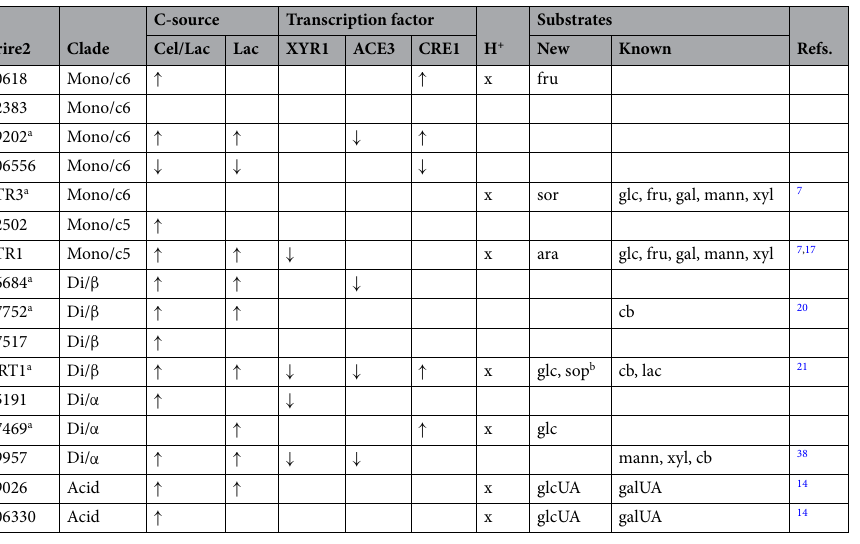
Table 1. T. reesei transporters tested in this study for symport activity in oocytes and their regulation by carbon sources and transcription factors. Clade refers to clades identified from Fig. 1. Significantly differential expression (DE) by carbon sources or by transcription factors was inferred from published studies 23–25,29,36 . Cel/Lac = DE on cellulose or lactose versus d-glucose 36 , Lac = DE on lactose versus glycerol or d-glucose 23 , XYR1 = DE on cellulose or α -sophorose between (cid:31) xyr1 and parental QM9414 strains 24 , ACE3 = DE on lactose between (cid:31) ace3 and parental QM6a strains 25 , CRE1 = DE on d-glucose between (cid:31) cre1 and parental QM9414 strains 29 . H + indicates symport activity detected in this study. Abbreviations as in Fig. 1. a Sequence differs from that listed in the QM6a genome assembly (See Materials and methods). b α